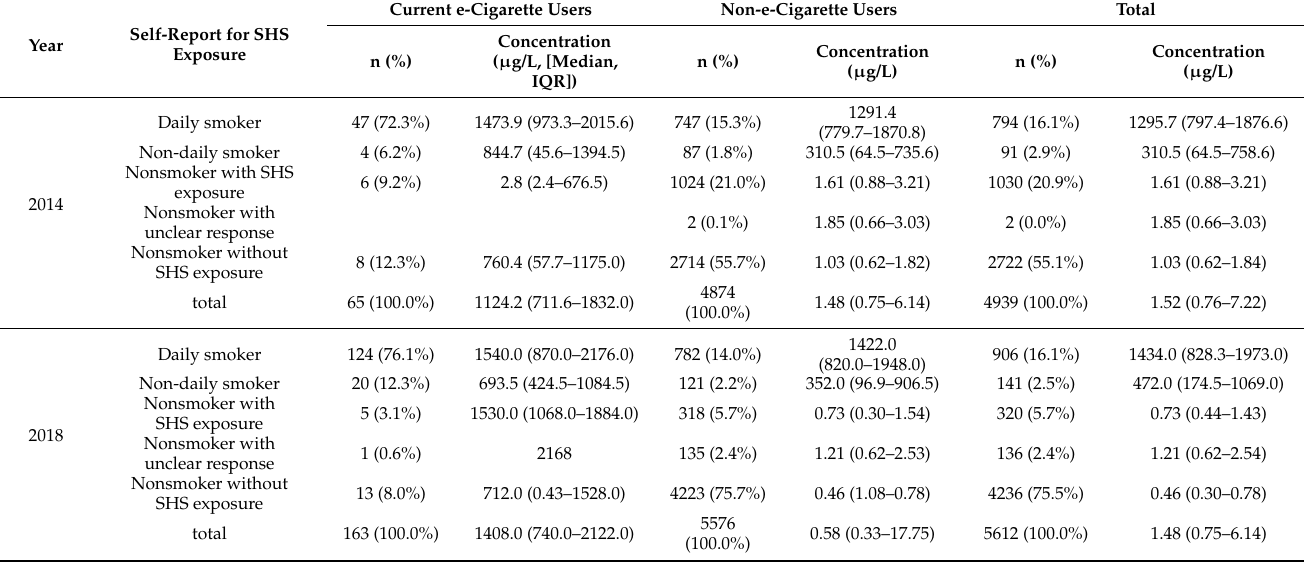
Table 4. The comparison between self-report for use of e-cigarettes and urinary cotinine concentration in self-report